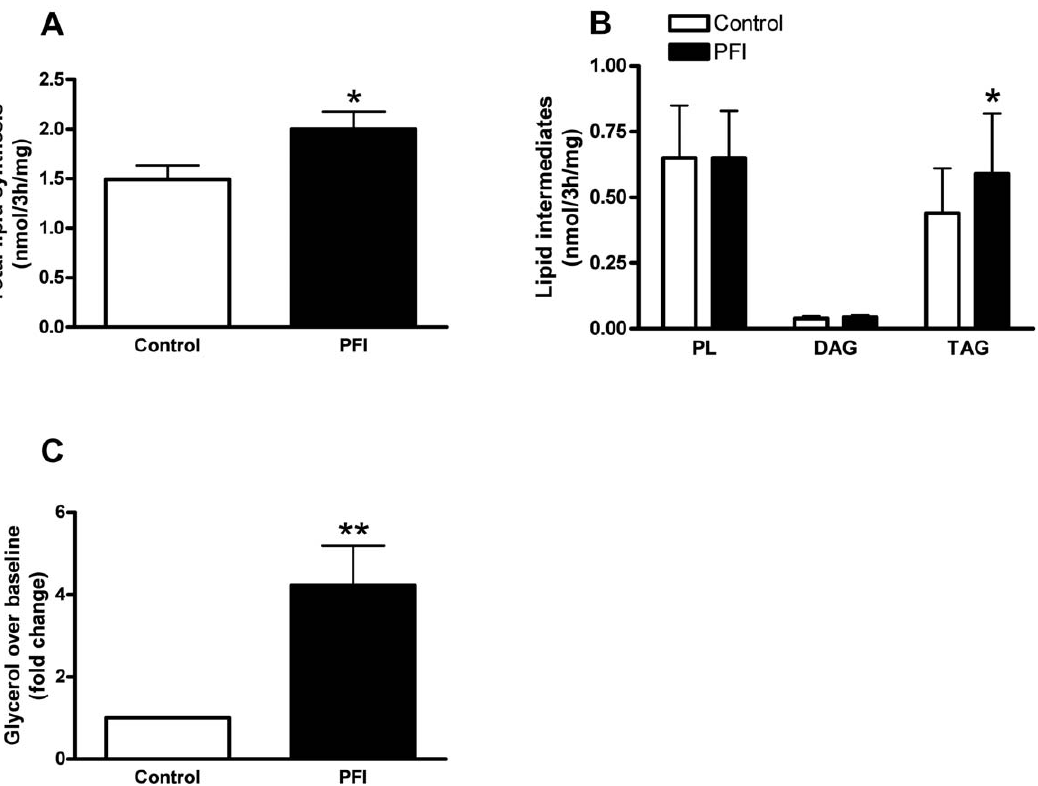
species such as phospholipids (PL), diacylglycerol (DAG), and triacylglycerol (TAG) rates of synthesis were measured by thin-layer chromatography. (C) Lipolysis measured as glycerol release was determined by subtracting baseline values to values during the stimulation with 1 m M of isoproterenol (a non-selective b -adrenergic agonist). The graph represents the changes in lipolysis at baseline in response to isoproterenol in control and PFI conditions. Data are expressed as mean 6 SEM of 4 separate experiments. * p , 0.05, ** p , 0.01 versus control.